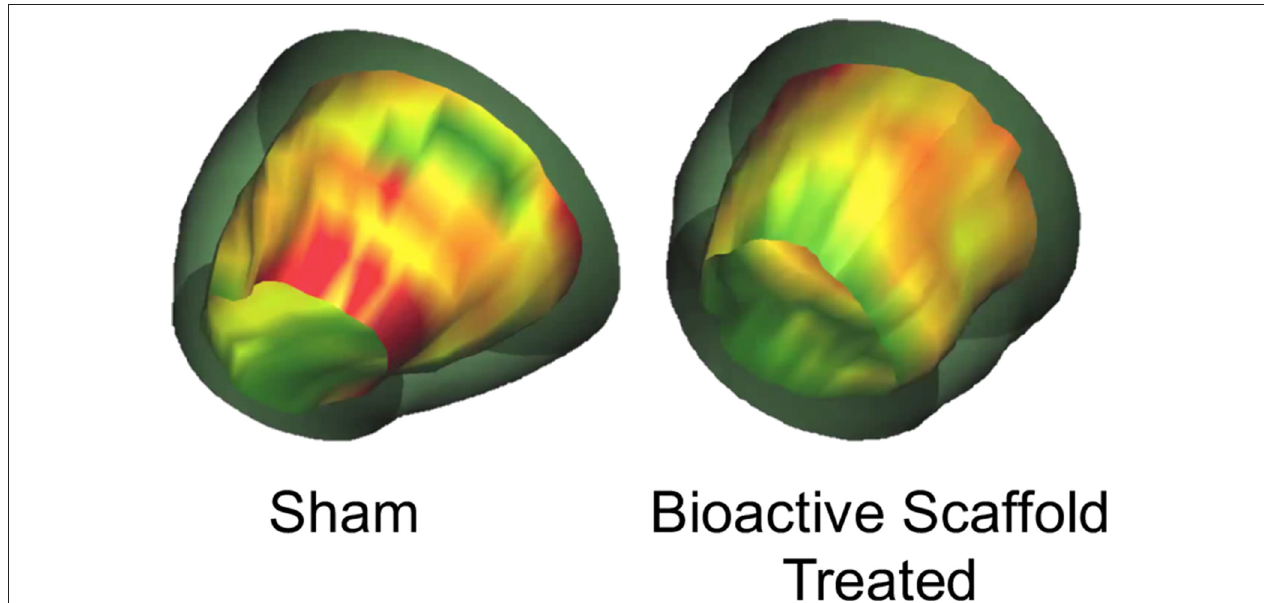
figURe 2 | 3-D images of the LV reconstructed from MRI data depicting wall thickening in sham versus bioactive scaffold-treated animals 6 weeks after the initial ischemic event (green = normal, yellow = hypokinetic, red = akinetic). Bioactive scaffold treatment resulted in regional improvement in myocardial function